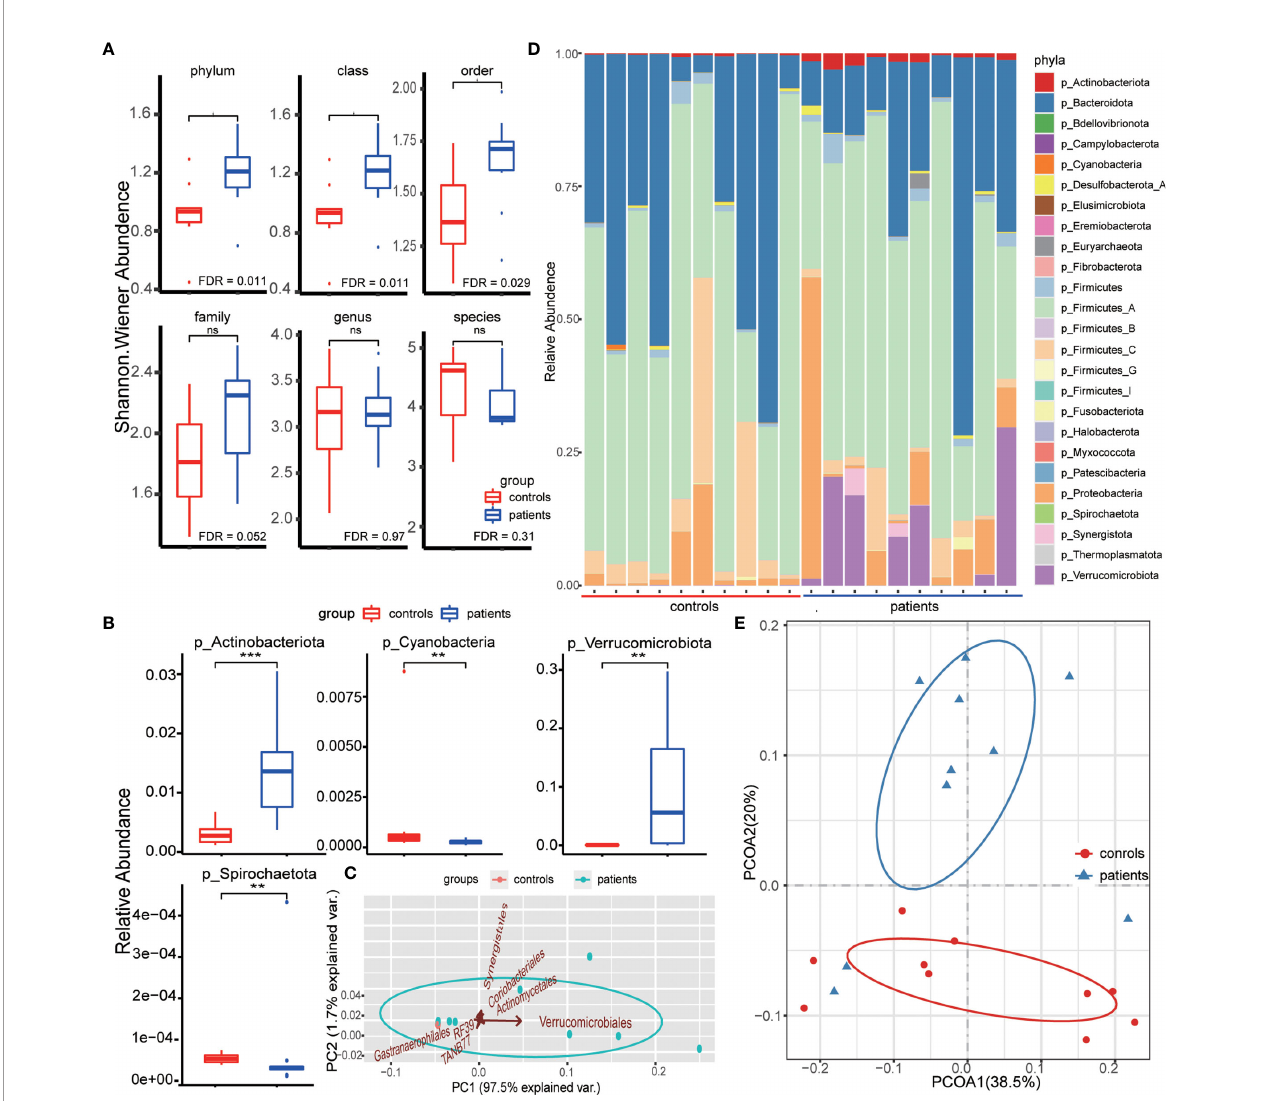
FIGURE 1 | (A) Comparison of diversity of each taxonomic level between patient and control groups. The taxonomic indexes and the Shannon Wiener indexes were compared by the Wilcoxon rank-sum test. (B) Differential phyla between groups identi fi ed by the Wilcoxon rank-sum test based on the relative abundance of bacterial phyla. ** means FDR < 0.01, *** means FDR < 0.001. (C) Principal component analysis (PCA) based on the relative abundance of differential orders between groups. The arrow direction represents the correlation between the phyla relative abundance and the principal component, and the arrow length indicates the contribution of corresponding taxonomic order in discriminating patients and controls. (D) Phyla composition of each sample. The bar length indicates the relative abundance of each phyla composition, and the total bacterial composition is 1. (E) Principal coordinate analysis between two groups based on the weighted unifrac distance. The ellipse represents the core area added by the group according to the default con fi dence interval. ns means no statistical signi fi